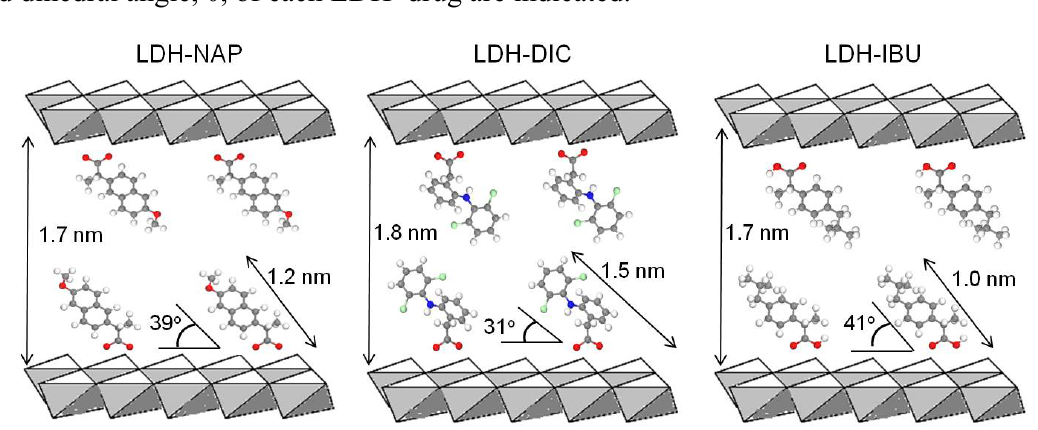
Figure 3. Schematic representation of the bilayer stacking of naproxen, diclofenac or ibuprofen anions between the LDH layers. The interlayer spacing, drug molecule length and dihedral angle, θ , of each LDH–drug are